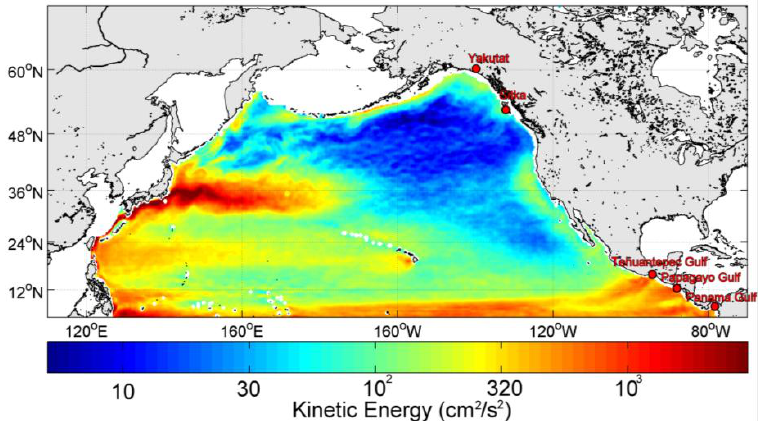
Figure 9. Spatial distribution of kinetic energy in the North Pacific calculated from altimeter absolute dynamic topography (ADT) data and averaged over the 20-year